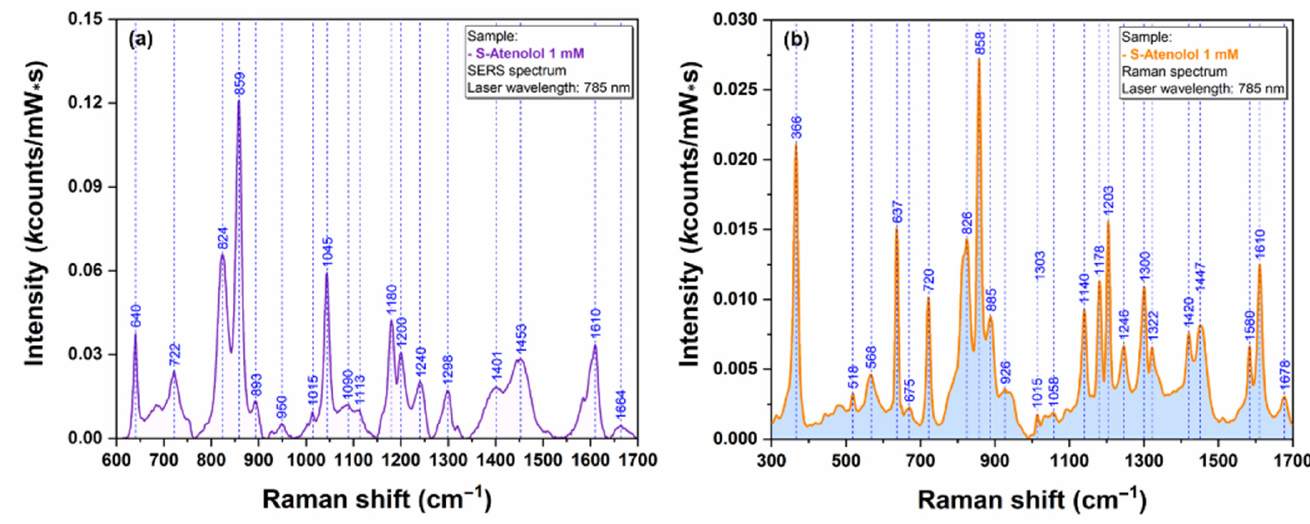
Figure 10. SERS spectrum of ATE 1 mM ( a ) collected on individual AgNS using a 785 nm laser. Raman spectrum of ATE 1 mM ( b ) collected using a 785 nm laser.